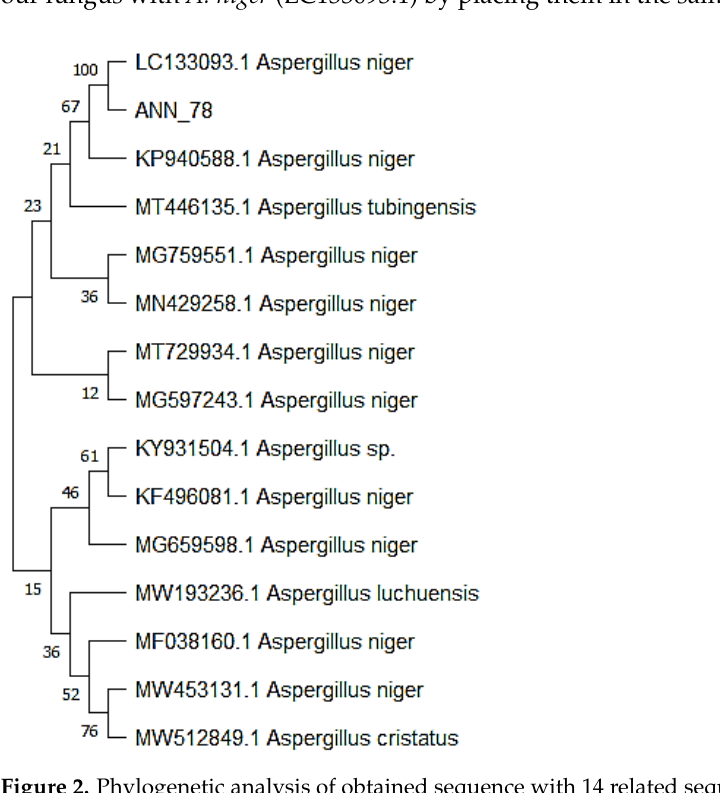
Figure 2. Phylogenetic analysis of obtained sequence with 14 related sequences.